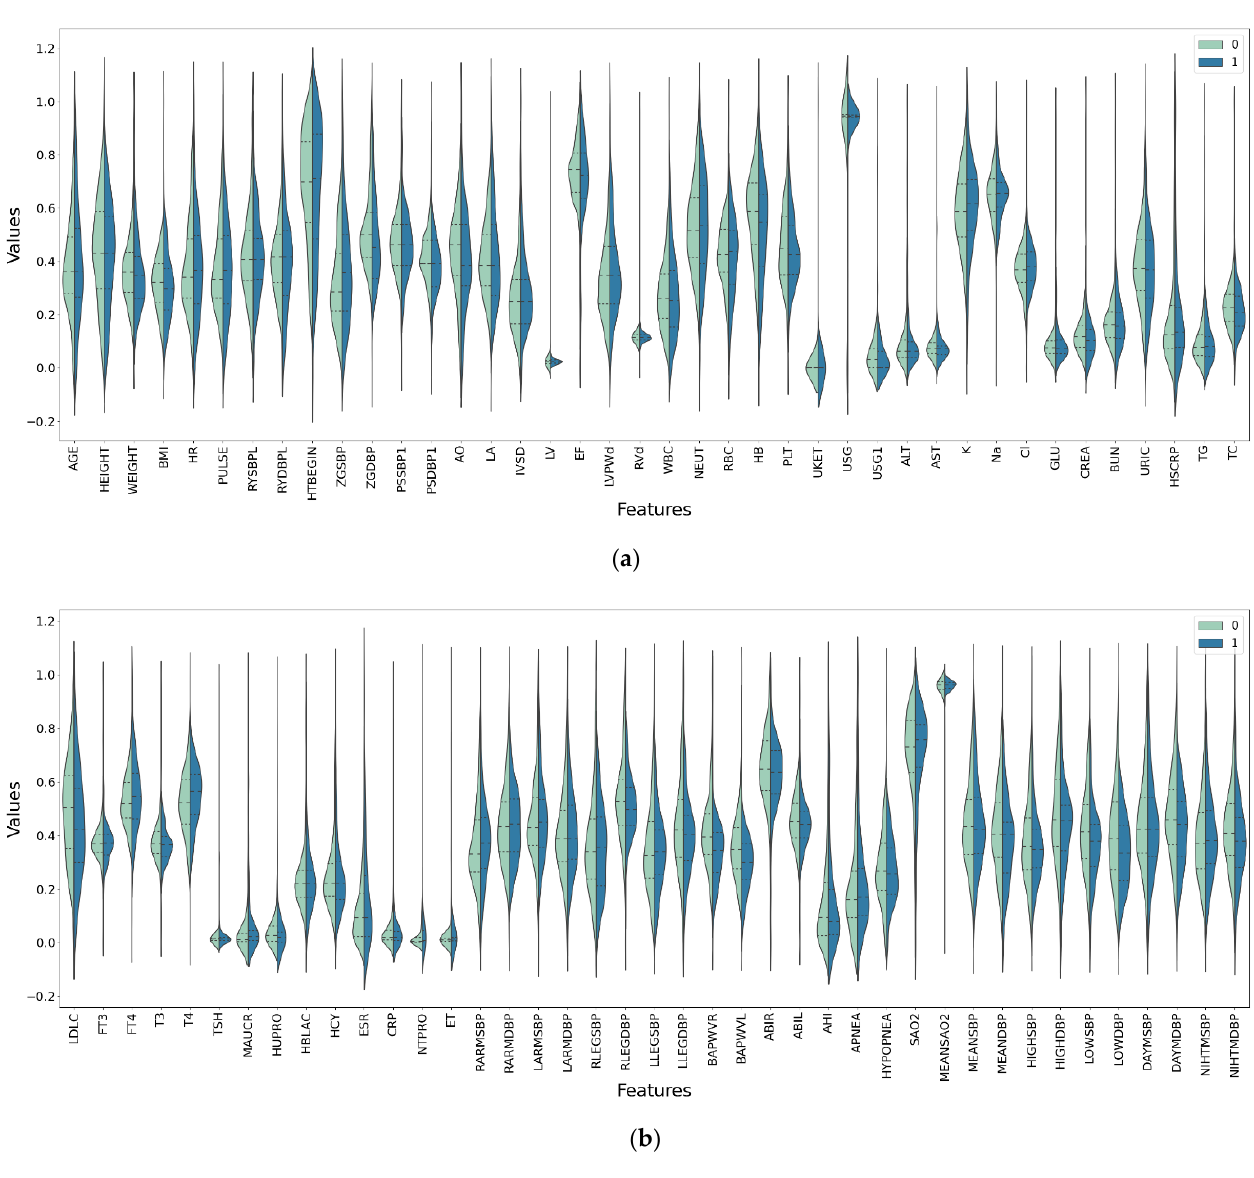
Figure 8. Violin plot of medical data after preprocessing. ( a ) The first 40 features. ( b ) The last 41 features.